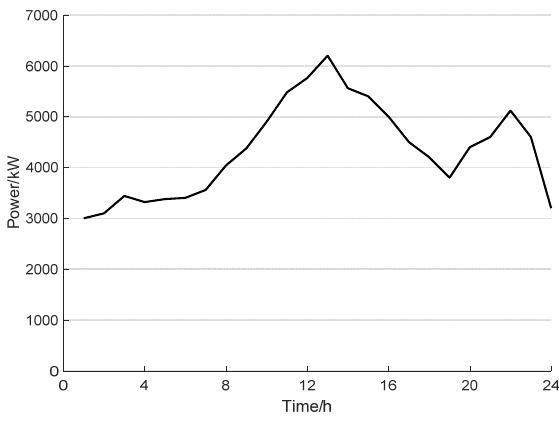
Figure 5. Target load curve. Table 1. Electricity trading prices of each